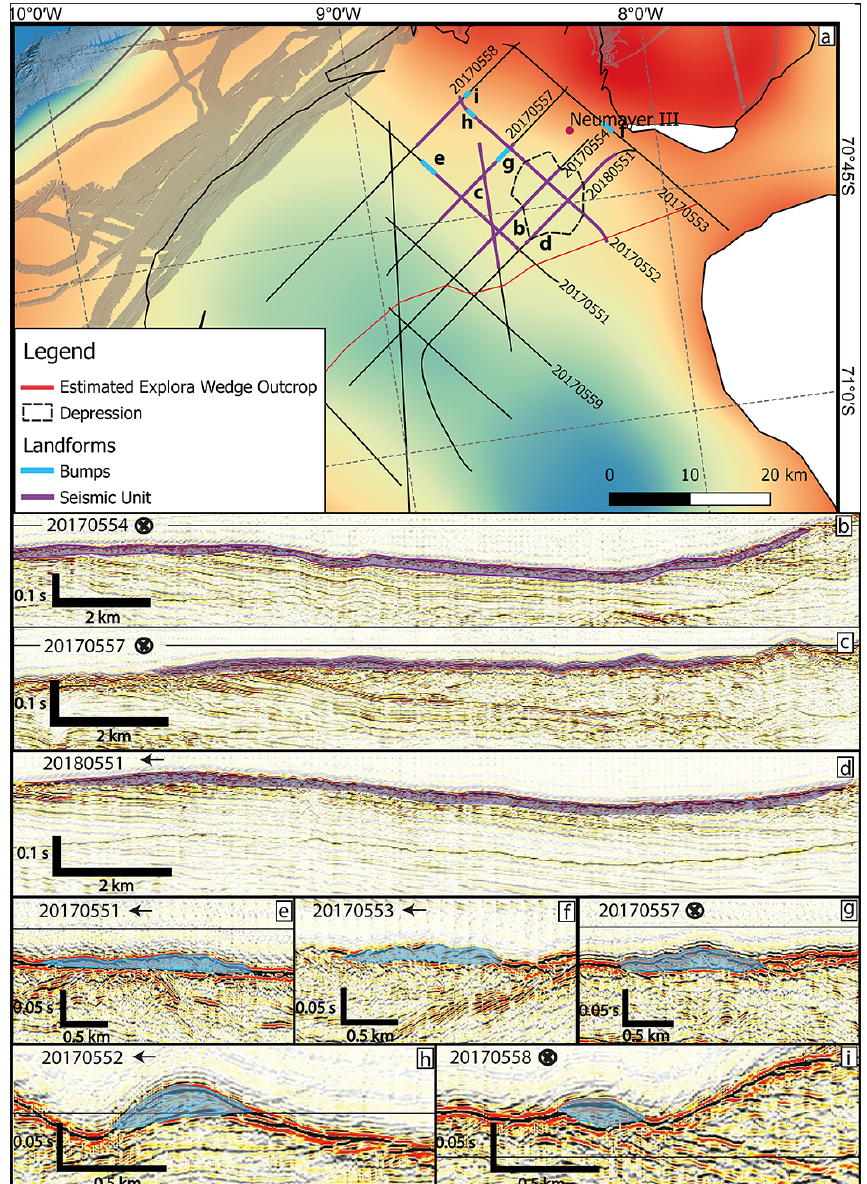
Figure 4. Landforms downstream of the Explora Wedge. Panel (a) provides an overview of the found landforms. Panels (b) – (d) display examples for the seismic unit interpreted as subglacial till, and (e) – (i) show the bumps in sediment. The arrows indicate the direction of the current ice flow with respect to the seismic line, and the (x) symbol indicates that the seismic line is parallel to the ice flow